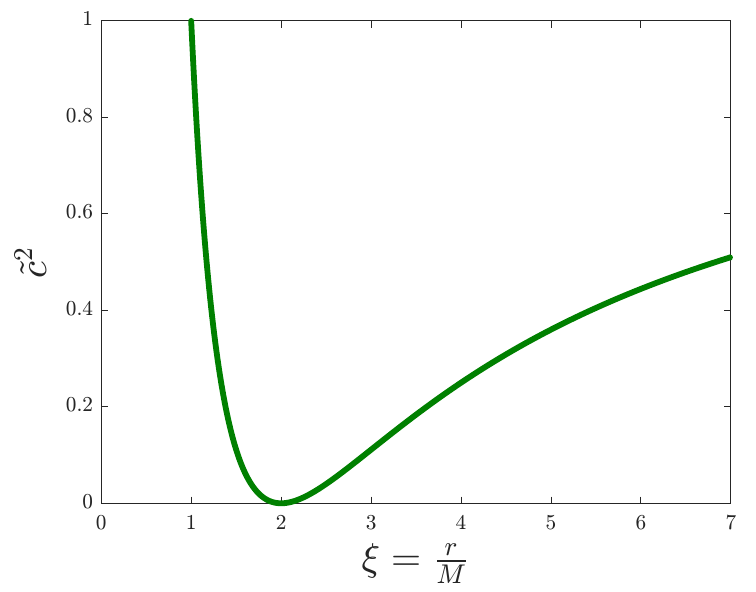
Figure 2. Effective speed of light squared ˜ c 2 versus the adimensional distance ξ = r / M for the simulation of a Schwarzschild black